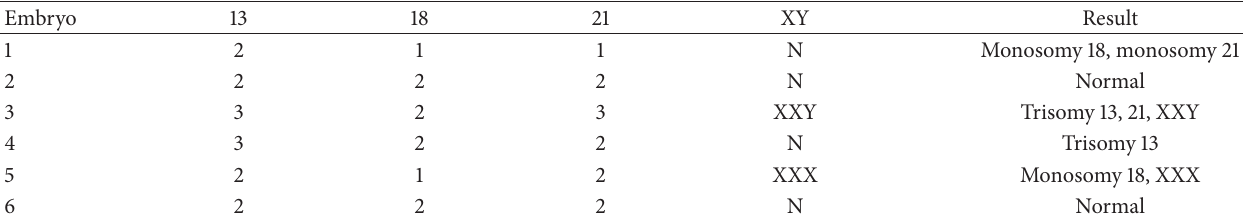
Table 1: Result of PGS by FISH examination.